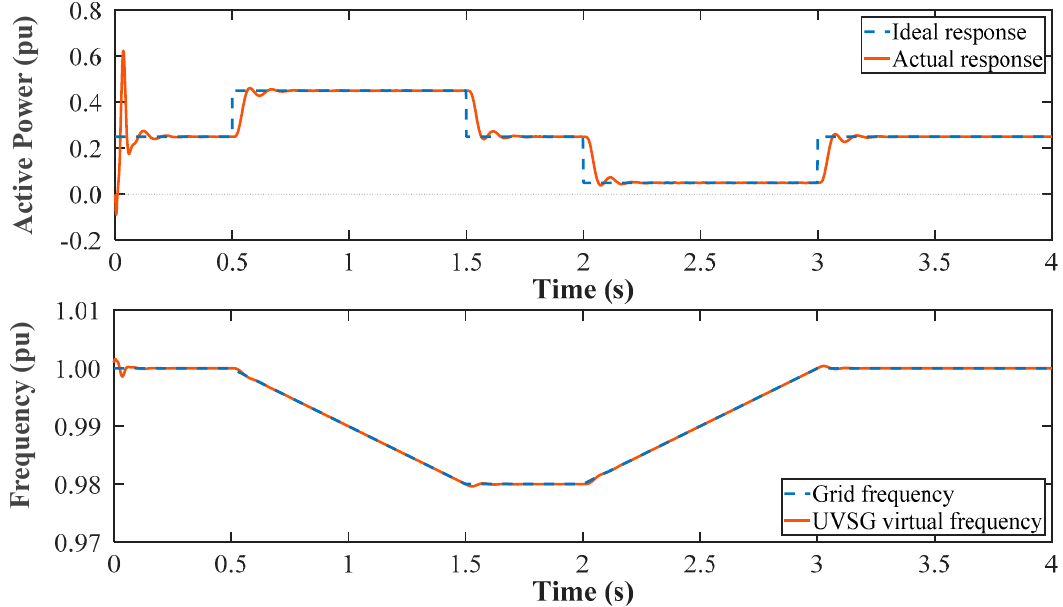
Figure 8. Simulation of inertial response of a PV system with H = 5 s, under ROCOF = 0.02 pu (1 Hz/s).